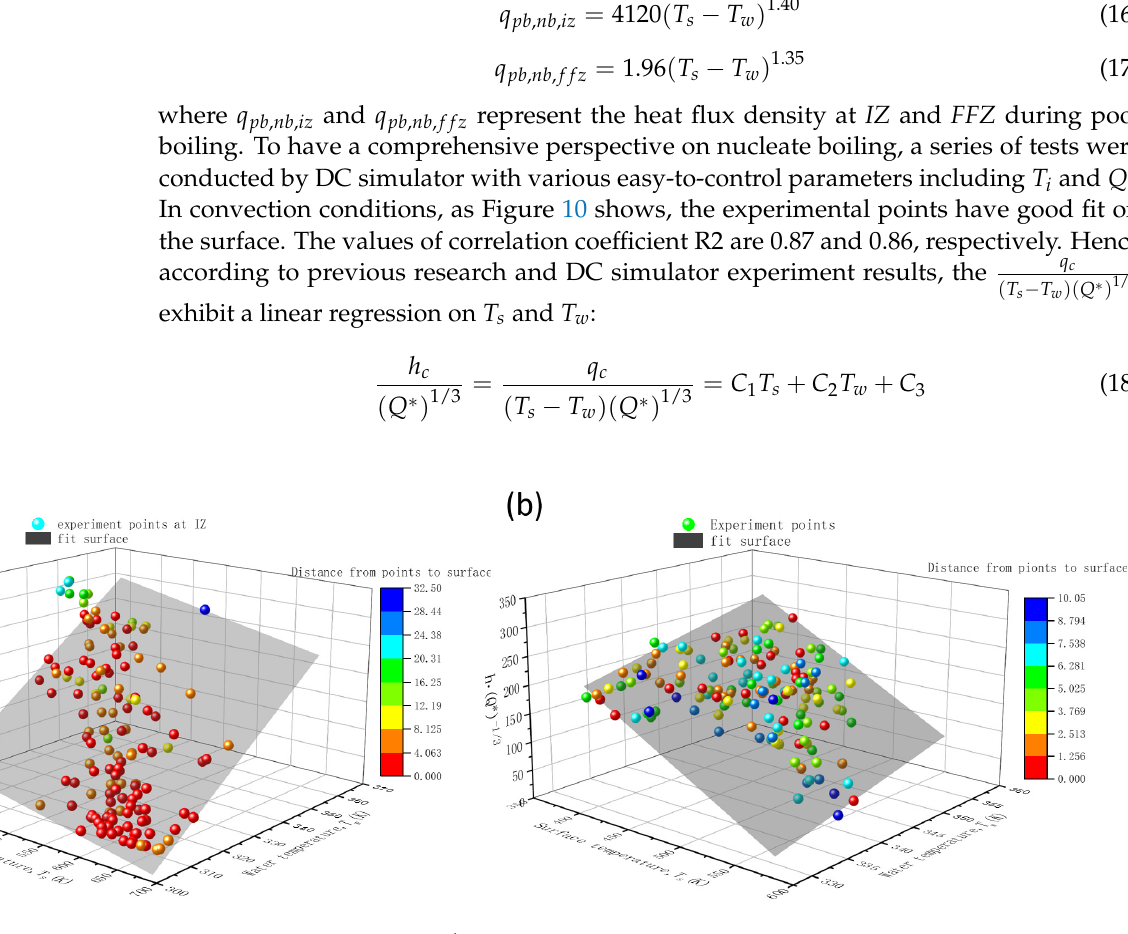
Figure 10. Comparison of h values conducted by DC secondary cooling simulator and fitted surface based on Equation (18): ( a ) at impingement zone ( IZ ); ( b ) at free-falling zone ( FFZ ). Double logarithmic graphs of q pb , nb and ( T s − T w ) are shown in Figure 11, an